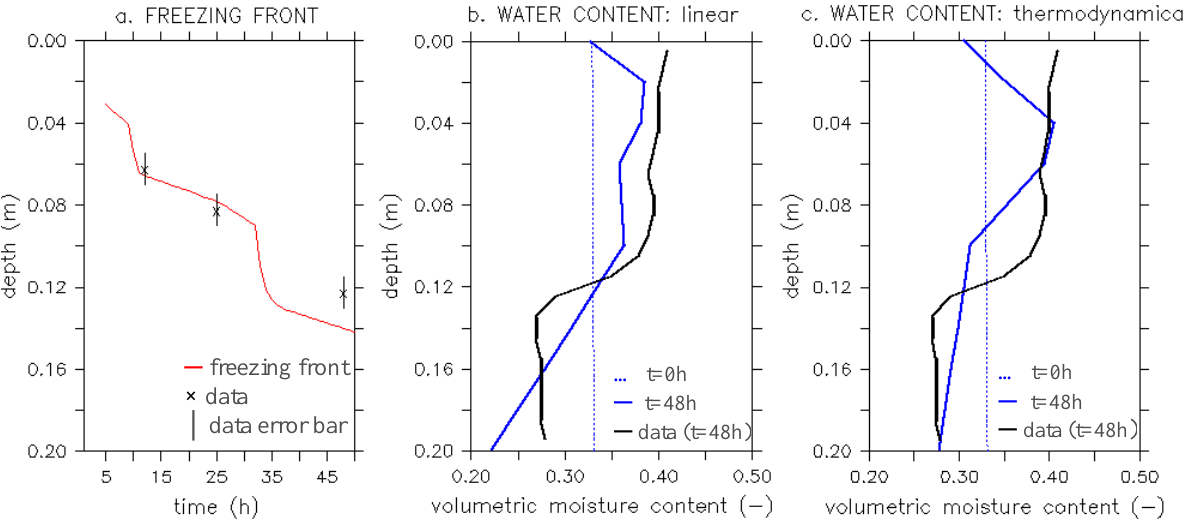
Fig. 5. Comparison between observed and modeled freezing front progressions and cryosuctions. (a) Modeled freezing front progression (red) and experimental data (points) with their error bars. The freezing front progression modeled with the linear and the thermodynamical freezing do not differ. (b) , (c) Total (frozen + unfrozen) soil moisture profiles as modeled by the linear (b) and thermodynamical (c) param- eterizations at the beginning and end of the Mizoguchi experiment (blue, t = 0h and t = 48h), and as observed at the end of the Mizoguchi experiment (black, data at t =